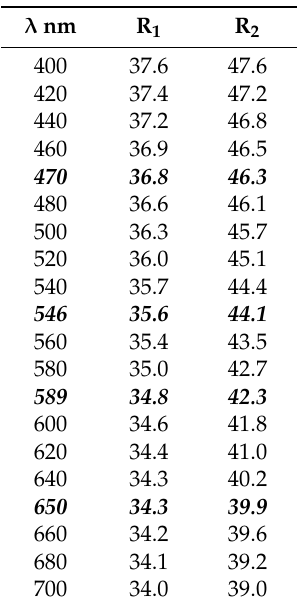
Table 1. Reflectance measurements of merelaniite using a WTiC standard taken in air. Measurements of R 1 and were taken on an axial cross-section, and R 2 measurements were taken on a longitudinal section. Interpolated COM (Commission on Ore Mineralogy) values are highlighted in boldface italics